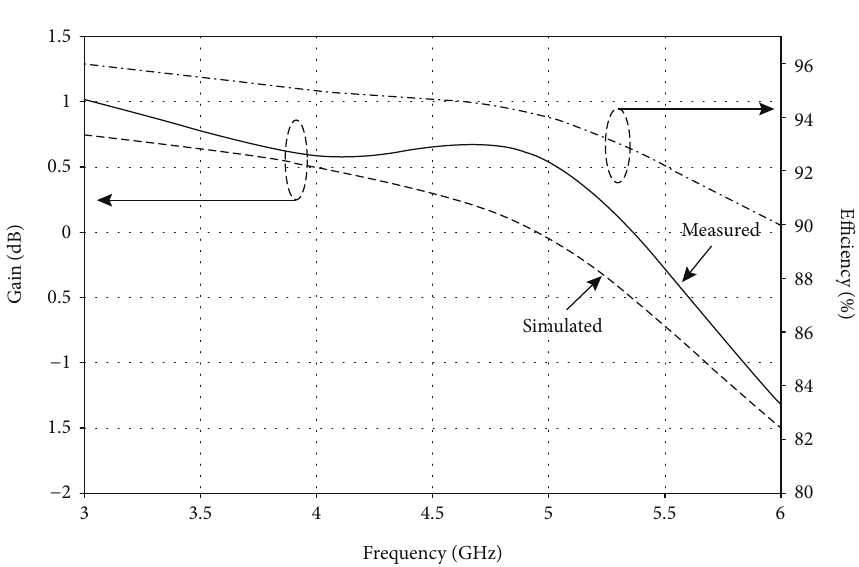
Figure 12: Measured group delay.